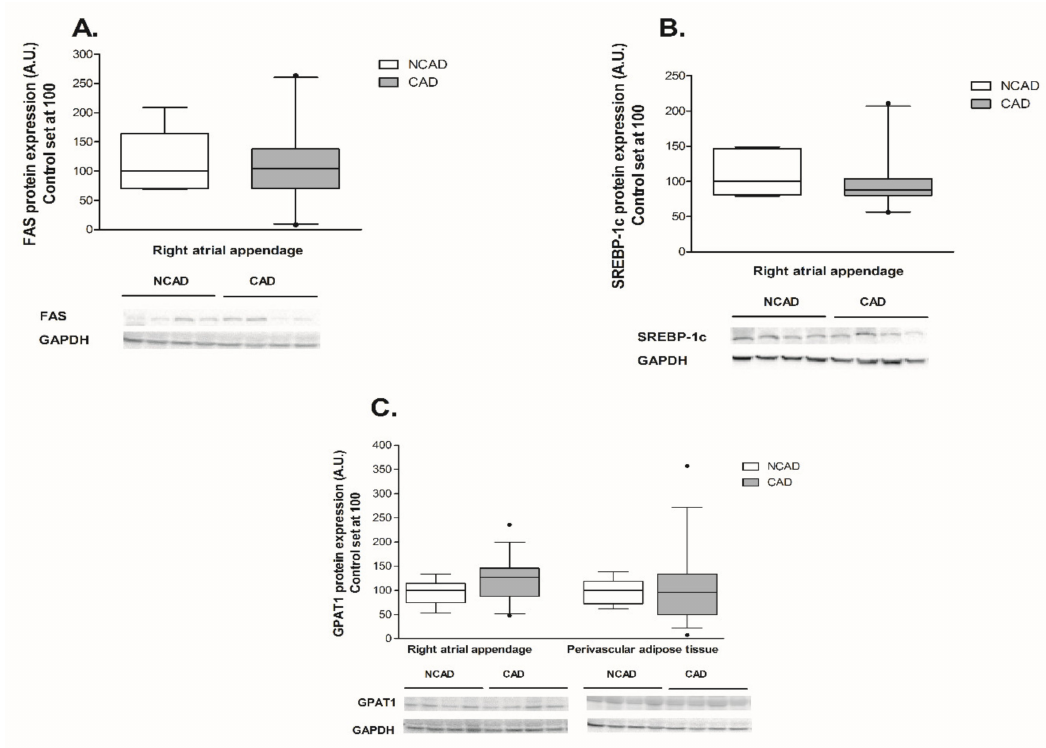
Figure 7. Myocardial proteins expression of ( A ) fatty acid synthase (FAS), ( B )sterol-regulatory-element-bindingprotein-1(SREBP-1c)andperivascularof( C )glycerol-3-phosphate acyltransferase 1 (GPAT1) in the coronary atherosclerosis (CAD, n = 42) and control (NCAD, n = 11) patients. Representative bands of WB analysis were shown. The inner horizontal line of a box represents the median. Box boundaries: 25–75 percentile; whiskers 5–95 percentile. Data are expressed as median ± SEM. For the sake of clarity, the control group median was set at 100, and the CAD group was scaled with respect to NCAD. * p < 0.05 vs. control